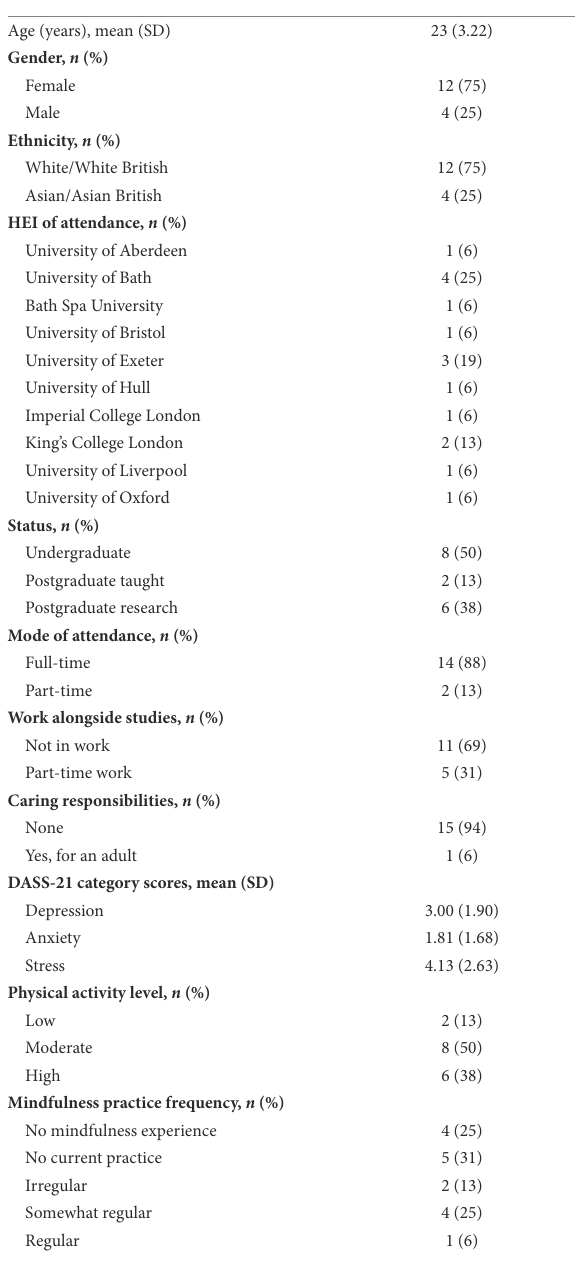
TABLE 1 Demographic characteristics of